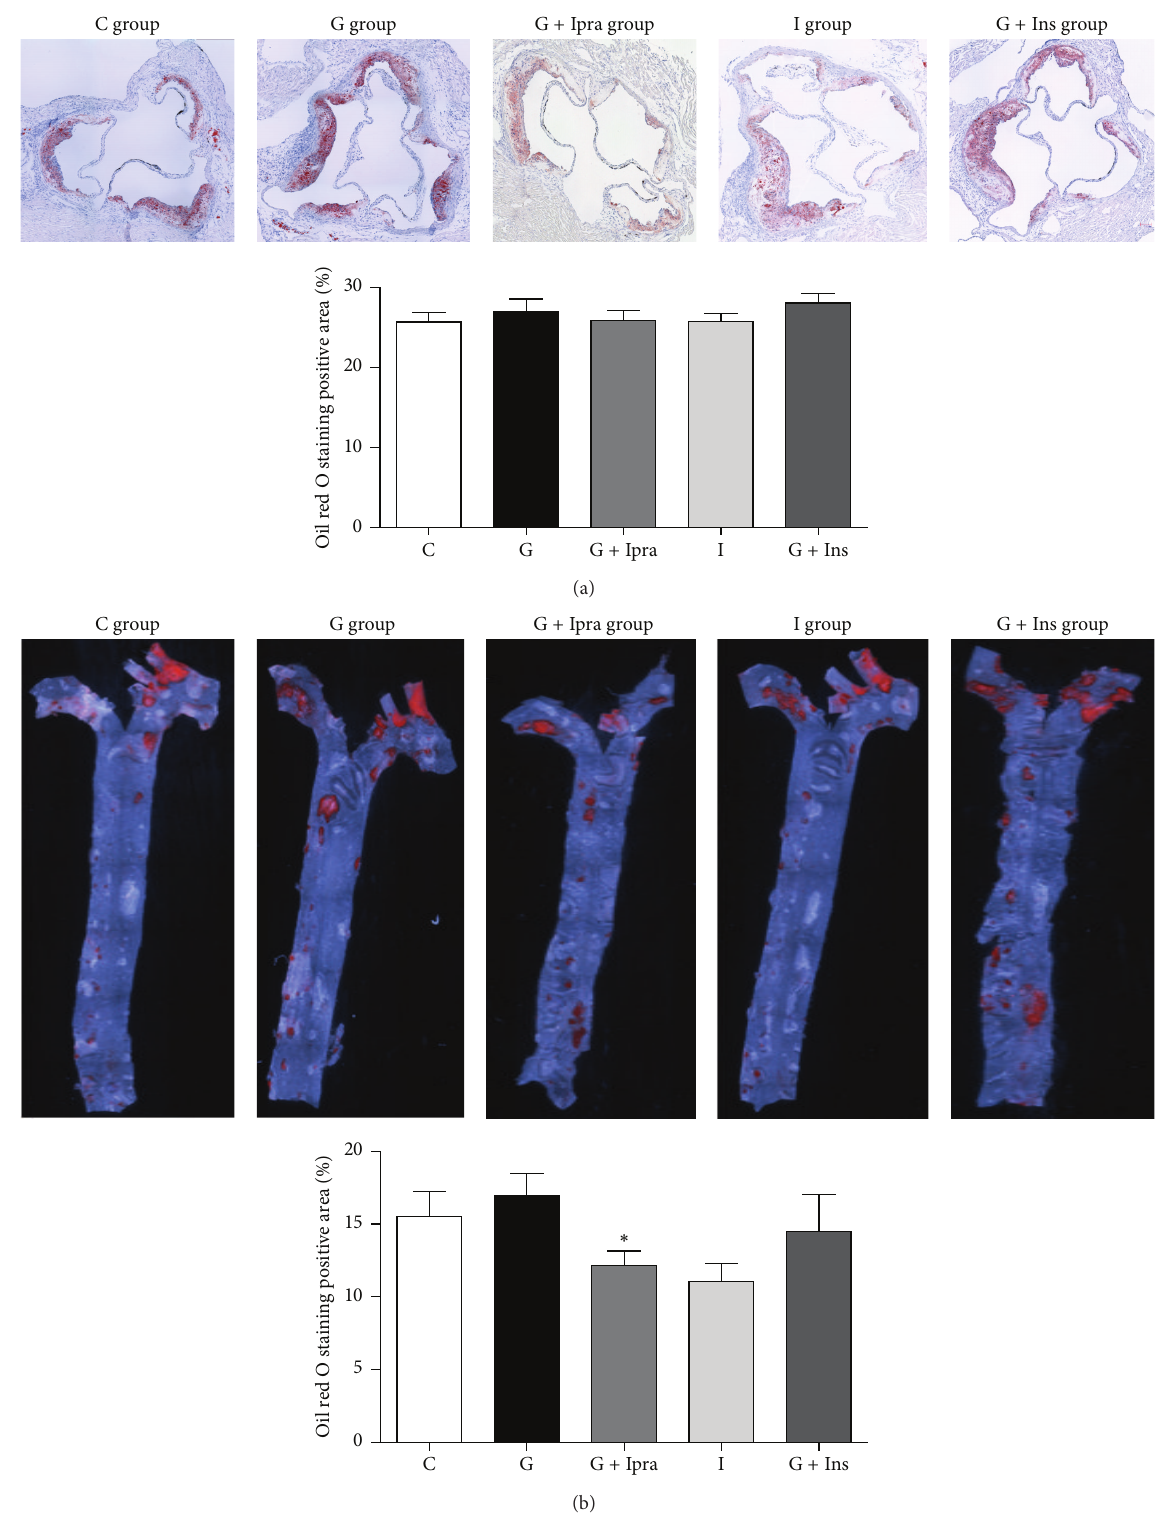
Figure 3: Atherosclerotic lesions in each treatment group. (a) Representative histological sections of aortic sinus stained with oil red O at 15 weeks after treatment. The area of oil red O-positive lesions in the aortic wall was evaluated. (b) Representative histological sections of the entire aorta stained with oil red O at 15 weeks after treatment. The area of oil red O-positive lesions in the entire aorta was evaluated. Data are mean ± SEM. ∗ 𝑃 < 0.05 versus the glucose group by Student’s 𝑡 -test. C group: control group ( 𝑛 = 21 ), G group: glucose group ( 𝑛 = 20 -21), G + Ipra group: glucose plus ipragliflozin group ( 𝑛 = 22 ), I group: insulin group ( 𝑛 = 16 -17), and G + Ins group: glucose plus insulin group ( 𝑛 = 19